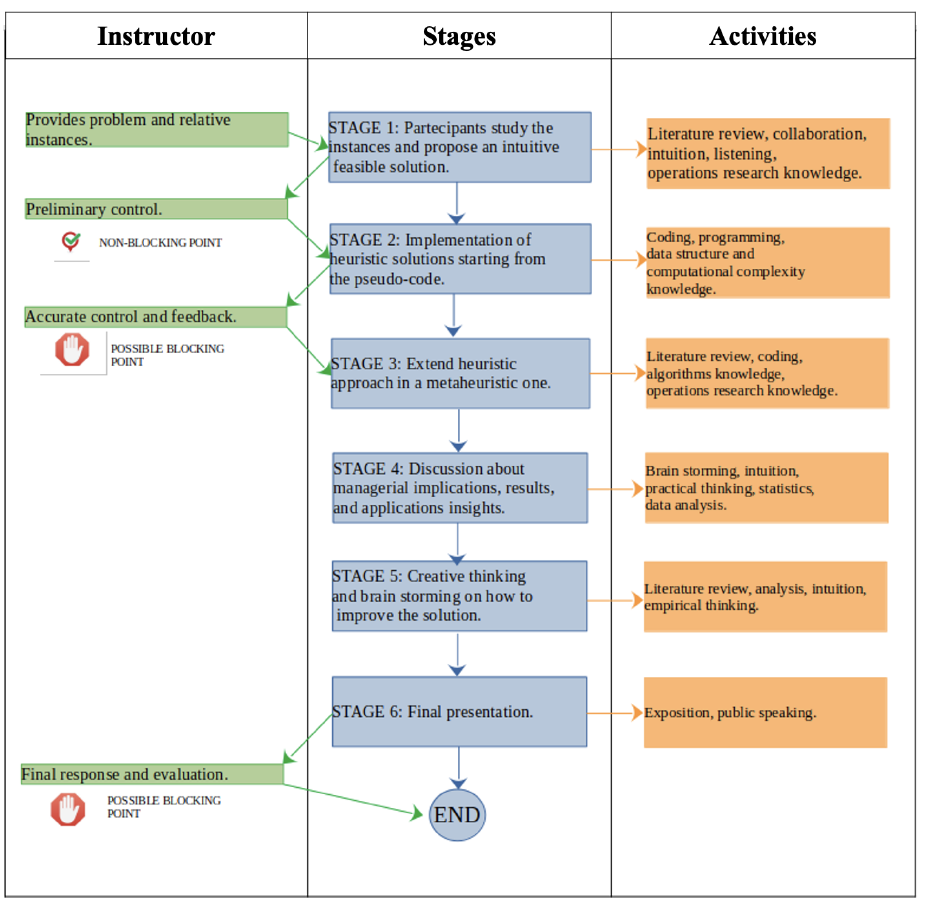
Figure 4. Representation of the game stages with relative required skills and responses by the